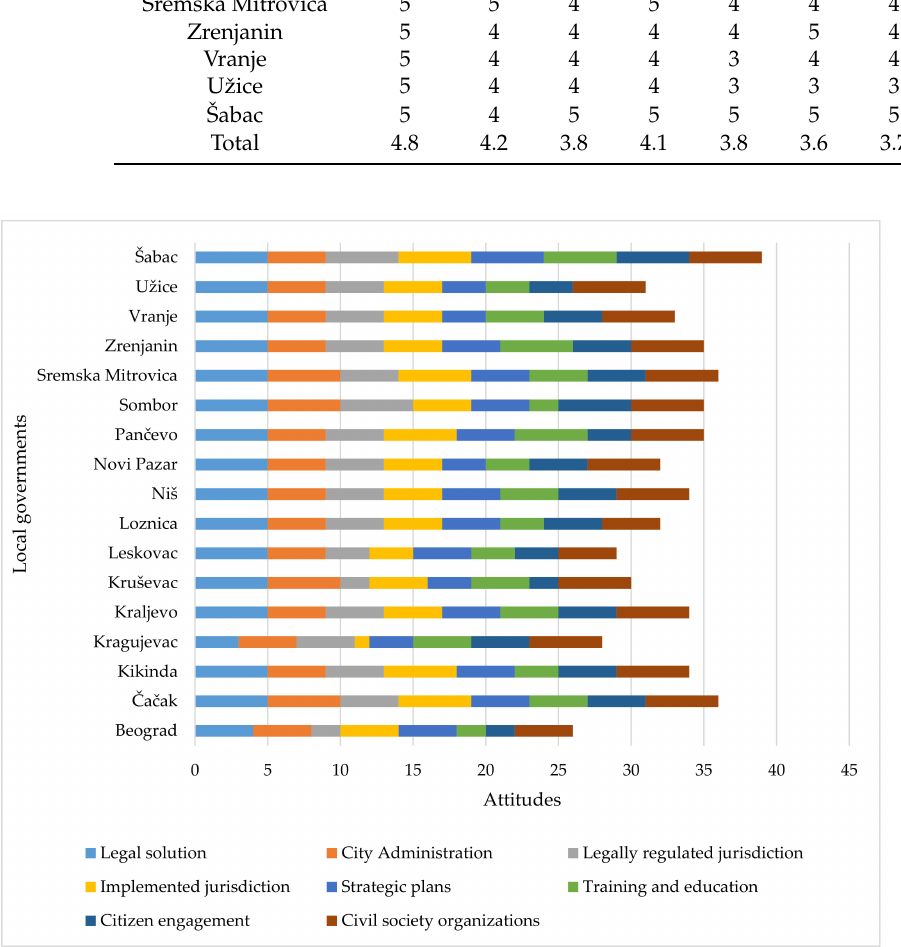
Figure 9. Attitudes of heads (mayor) of disaster sectors in local self-government